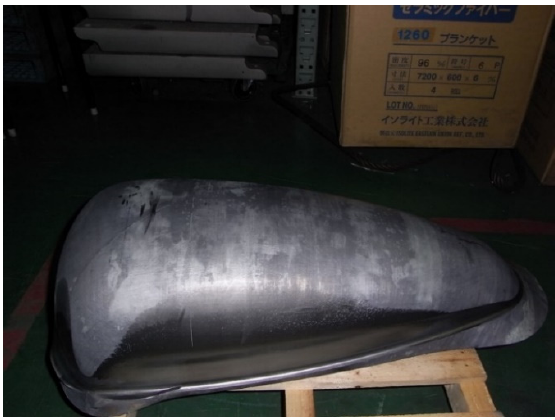
Figure 11. A member with the same shape as the product formed by hot-pressing.